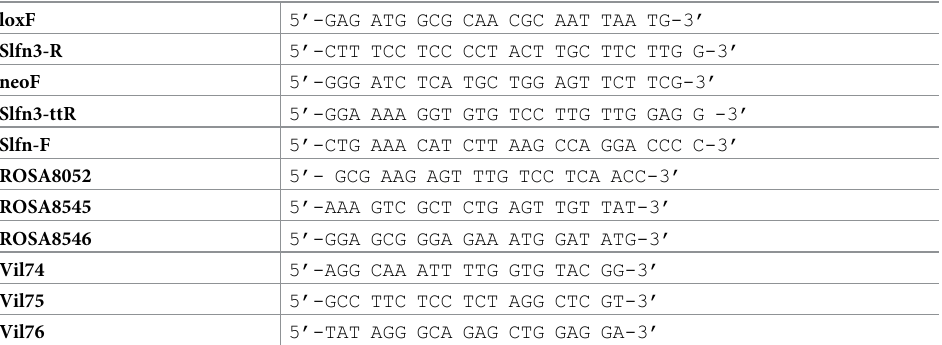
Slfn3 flox+/+ /Flp -/- to ultimately generate the Slfn3 flox+/+ / Flp -/- /Cre -/- Control (Ctrl) mice and the Slfn3 flox+/+ / Flp -/- /Cre +/- VC-Slfn3KO mice (S1 Fig). Genotyping protocols included isolating DNA from 2-4mm tails using the DNeasy Blood and Tissue kit and the Qiacube form Qiagen (Valencia, CA). The following PCR mix was used for genotyping PCR reactions of the Slfn3 β geo mice: 25 μ l total reaction = 1.3 M Betain (Sigma- Aldrich), 0.325 μ l DMSO, 1.75 mM MgCl , 1x Buffer without MgCl , 0.2 μ M forward primer, 2 2 0.2 μ M reverse primer, 0.2 mM dNTPs, 0.04 U/ μ l AmpliTaq DNA polymerase (ThermoFisher Scientific, Waltham, MA), 2 μ l DNA, and water. There are three primer pair combinations in separate genotyping PCRs utilized to genotype the Slfn3 β geo mice. The first was the LoxF reac- tion utilizing the loxF and Slfn3-R primers. The second was the NeoF reaction utilizing the neoF and Slfn3-ttR primers. The third was the WT reaction utilizing the Slfn3-F and Slfn3-ttR primers (Table 1). PCR parameters were as follows: denaturation, 94C for 5 min; 1 st annealing and extension, 94C for 15 sec, 65C for 30 sec, 72C for 40 sec, 10 cycles with 1C decrease per cycle; 2 nd annealing and extension, 94C for 15 sec, 55C for 30 sec, 72C for 40 sec, 30 cycles; final extension, 72C for 5 min; hold at 4C. PCR reactions were analyzed on a 1.5% agarose gel stained with ethidium bromide (S2A Fig). The Slfn3 flox+/+ /Flp +/+ mice were genotyped with the LoxF, NeoF, and WT PCR reactions above and also with the following PCR reaction from Jackson Laboratories, Flp reaction: 12 μ l total reaction = 2 mM MgCl , 1x Kapa 2G HS Buffer 2 without MgCl , 0.5 μ M of each primer: ROSA8052, ROSA8545, and ROSA8546 primer 2 (Table 1), 0.2 mM dNTPs, 0.05 μ l of 2.5 U/ μ l Kapa 2G HS Taq polymerase (Kapa Biosystems, Wilmington, MA), 2 μ l DNA, and water (protocol and primer sequences from Jackson Labora- tories). PCR parameters were as follows: denaturation, 94C for 2 min; 1 st annealing and exten- sion, 94C for 20 sec, 65C for 15 sec, 68C for 10 sec, 10 cycles with 0.5C decrease per cycle; 2 nd annealing and extension, 94C for 15 sec, 60C for 15 sec, 72C for 10 sec, 28 cycles; final exten- sion, 72C for 2 min; hold at 4C. PCR reactions were analyzed on a 1.5% agarose gel stained with ethidium bromide (S2B Fig). The Slfn3 flox+/+ / Flp -/- /Cre +/- (VC-Slfn3KO) and Slfn3 flox +/+ / Flp -/- /Cre -/- (Control (Ctrl) mice) were genotyped with the following LoxF and WT reac- tions (which are modifications to the original genotyping protocols from above). The LoxF qPCR reaction mix included 1x SybrGreen buffer (BioRad, Hercules, CA), 250nM loxF primer, 250nM Slfn3-R primer, 2 μ l DNA, and water to a total volume of 20 μ l. qPCR analysis was performed using the BioRad CFX976 Touch Real-Time Detection System with the follow- ing parameters: denaturation, 94C for 3 min; 1 st annealing and extension, 94C for 10 sec, 65C for 30 sec, 10 cycles with 1C decrease per cycle; 2 nd annealing and extension, 94C for 10 sec, 55C for 30 sec, 30 cycles, and then a melt curve was run. The WT PCR reaction mix included 1.3 M Betain, 1x GoTaq G2 Green Master Mix (Promega, Madison, WI), 0.2 μ M Slfn3-F Table 1. Genotyping